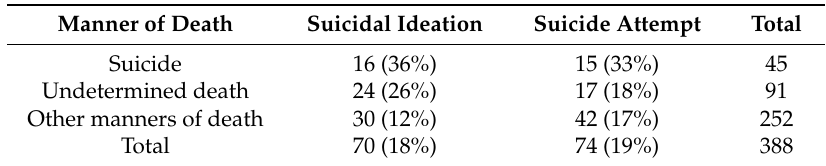
Table 4. Suicidal ideation and suicide attempt by manner of death according to case record evaluation in the long-term